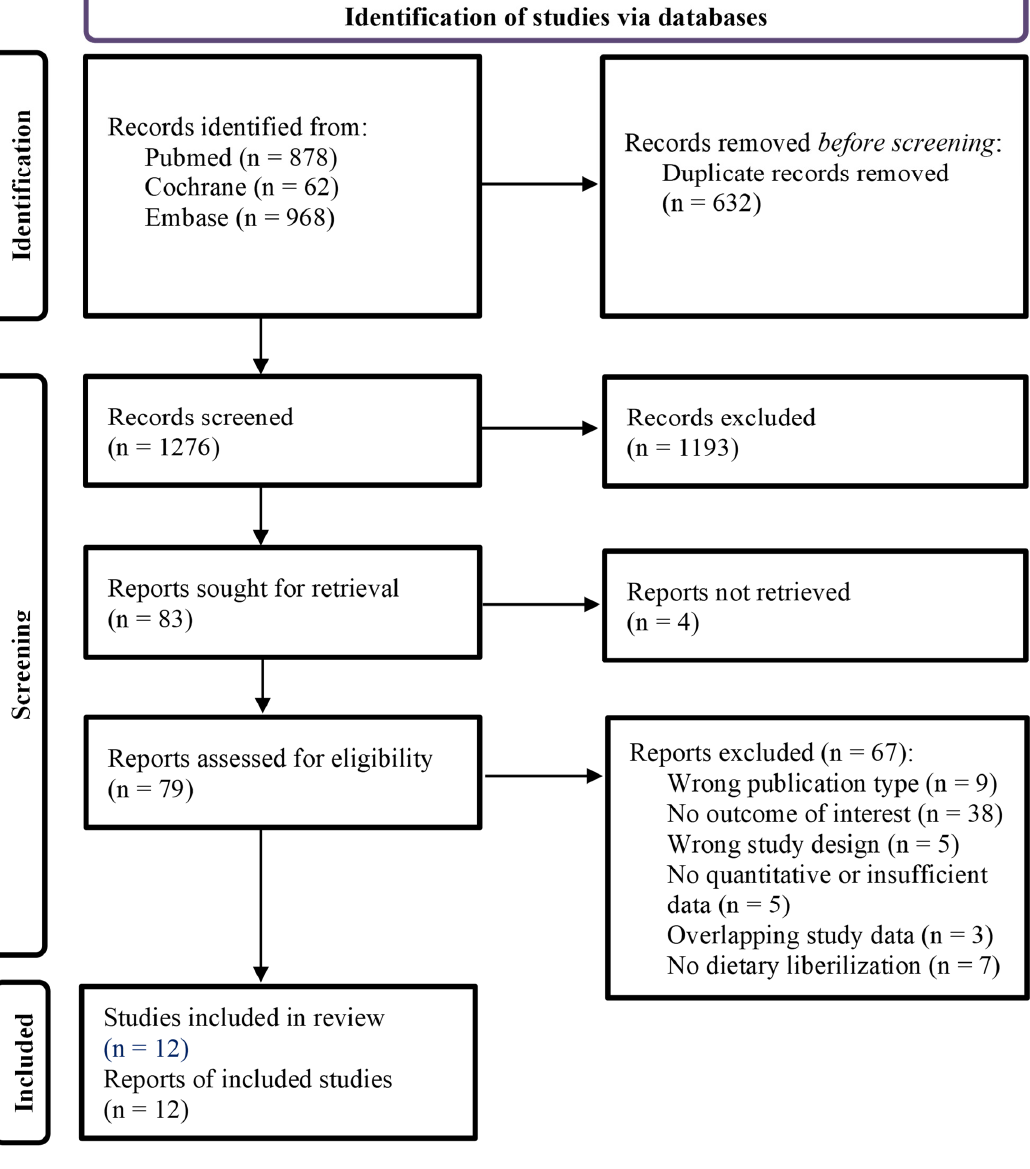
Figure 1. Flowchart of the study inclusion.